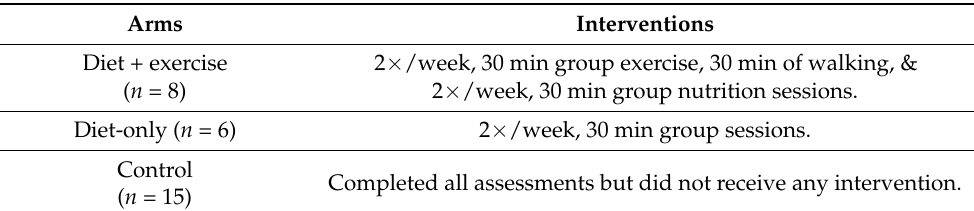
Table 1. Trial arms: duration, frequency, and details. Arms Interventions Diet +